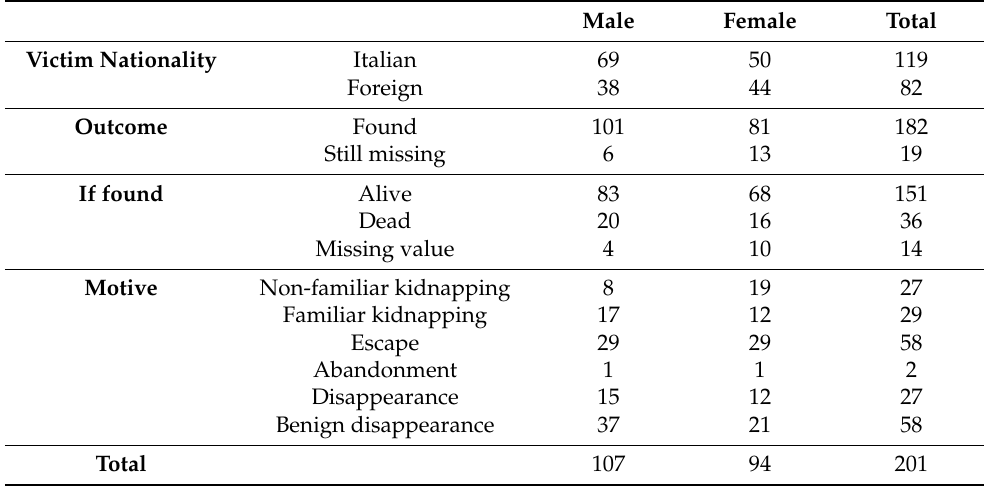
Table 1. Descriptive information about children’s disappearance, by gender.